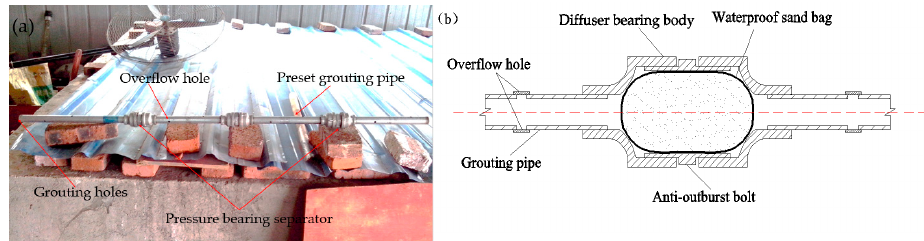
Figure 2. The internal preset device: ( a ) the physical picture of the internal preset device, ( b ) the principle of pressure bearing separator.